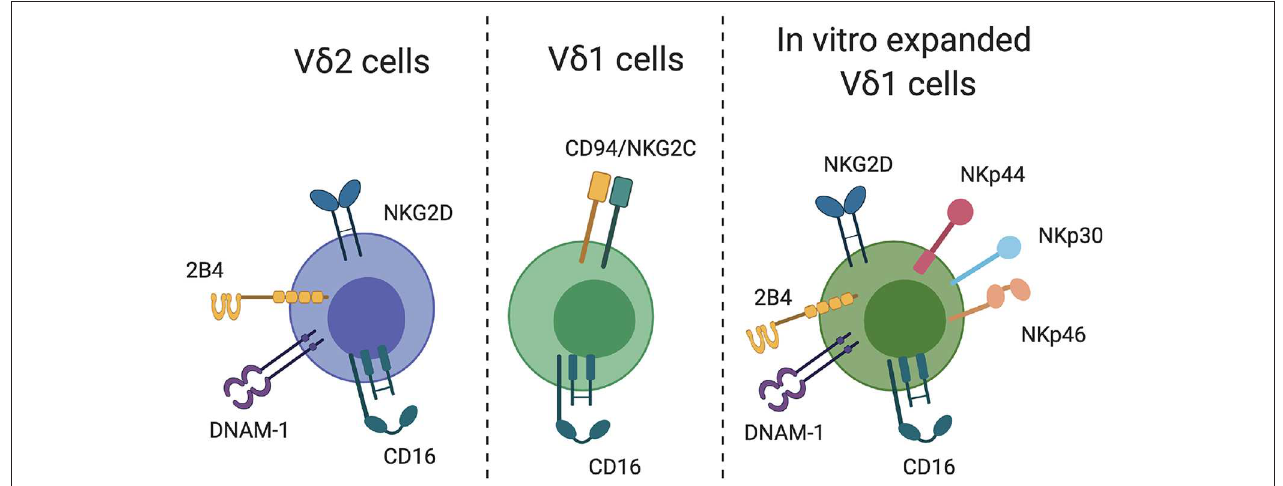
FIGURE 1 | γδ T cell recognition of target cells. Relevant receptors that may facilitate γδ T cell recognition of HIV-infected CD4T cells are indicated for V δ 2, V δ 1, and in vitro -expanded V δ 1 cells.